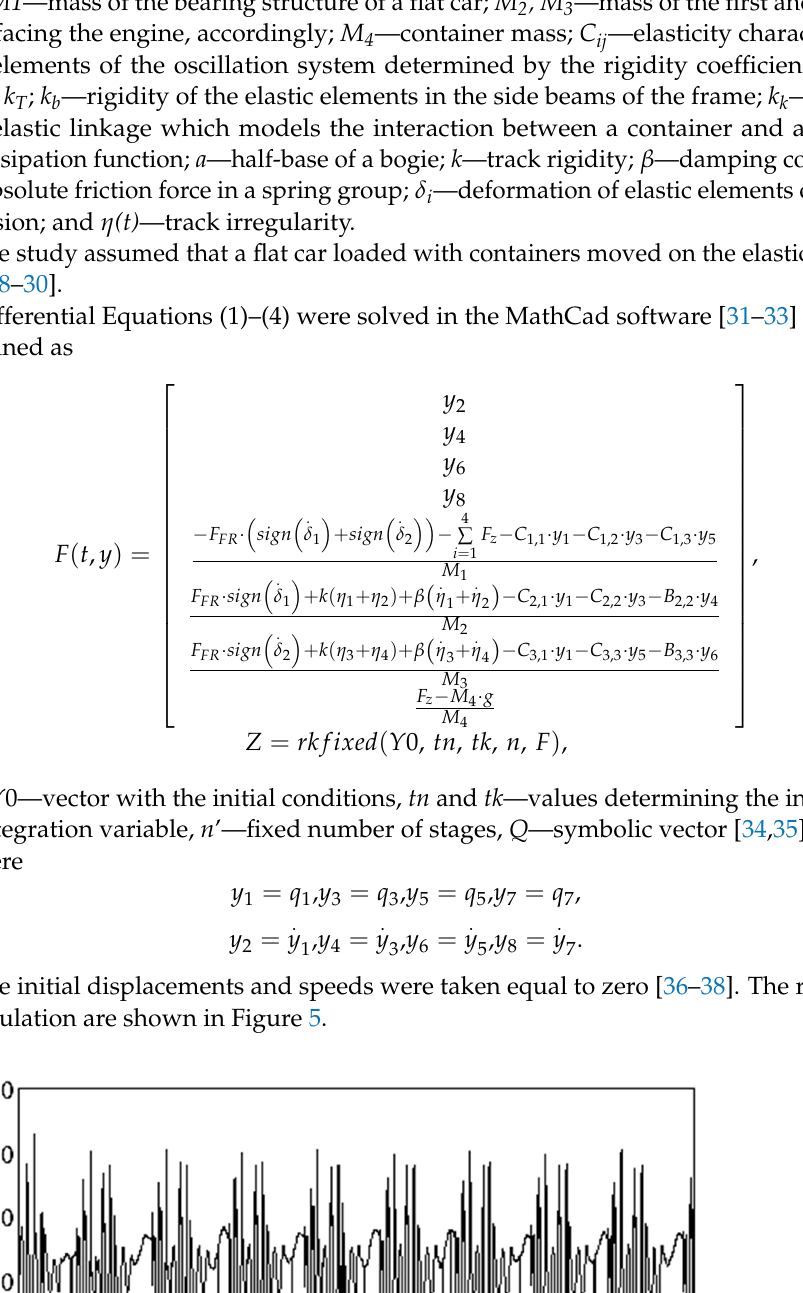
(6) where M FLgw —gross weight of a flat car; P l —longitudinal impact force to the automatic coupler; n—number of containers on a flat car; F FR —friction force between fixed lashing components and fittings; M k —container mass; C e —rigidity of elastic elements in the fit- tings of a container; q 1 , q 2 —coordinates determining the displacements of a flat car and a container relative to the longitudinal axle. The system of differential Equation (6) was solved in the MathCad software complex as